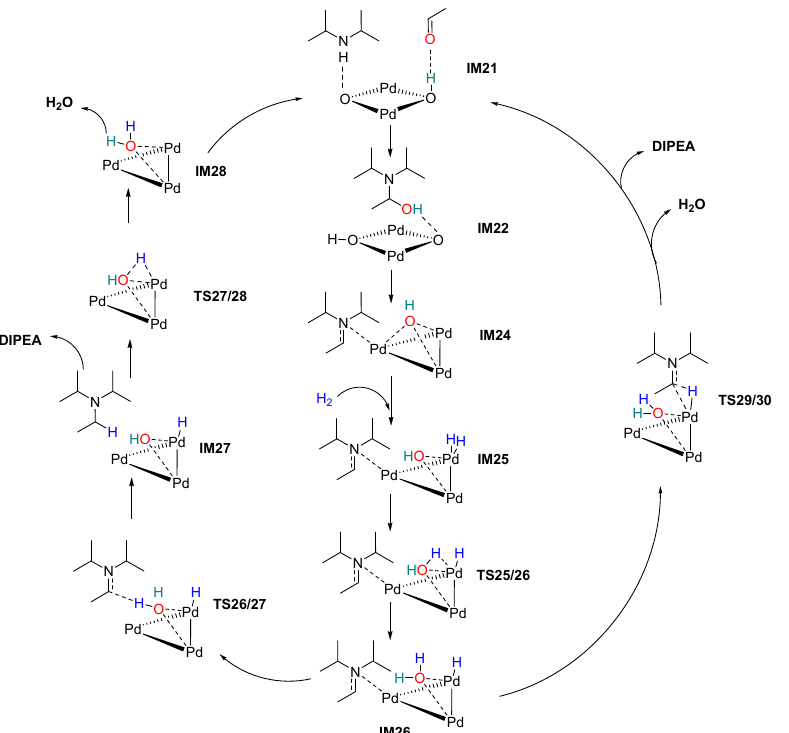
Scheme 1. Proposed mechanism for the generation of N,N-Diisopropylethylamine mediated by the Pd 8 O 12 H 8 cluster. To examine the versatility of the reduction amination on Pd(OH) 2 /g-C 3 N 4 , various aldehydes and amines (mainly secondary ones) were used as the substrates (Table 2), es-